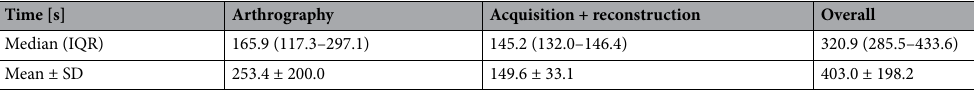
Table 5. Examination time. Time requirements for fluoroscopy-guided three-compartment arthrography with subsequent ultra-high-resolution cone-beam CT using the gantry-free twin robotic X-ray system. Time intervals were recorded for each step of the arthrogram and 3D imaging process by a dedicated timekeeper. IQR interquartile range, SD standard